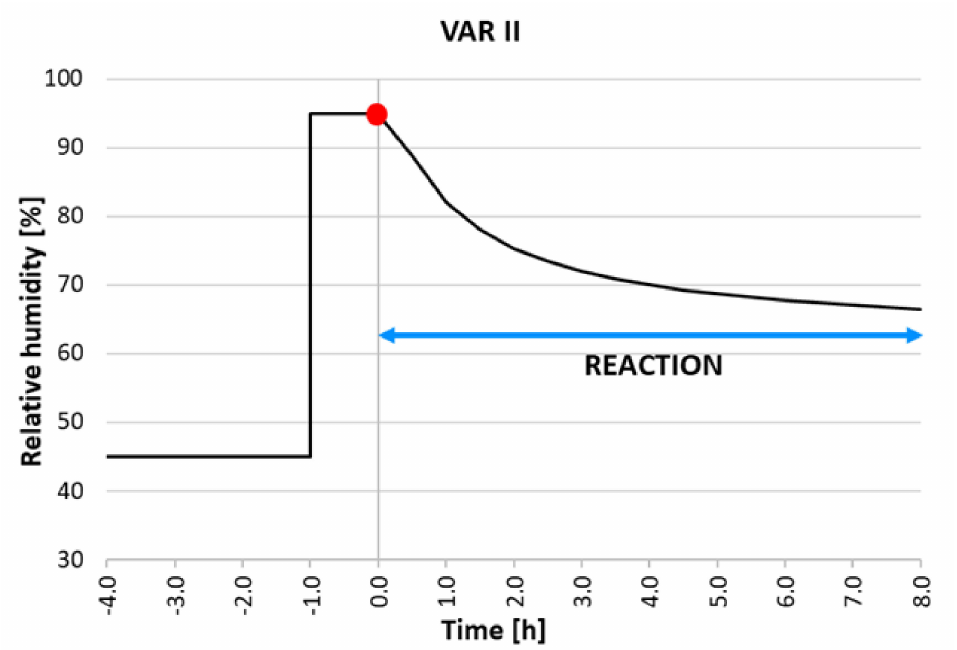
Figure 4. Scheme of the proposed methodology: dynamic adsorption